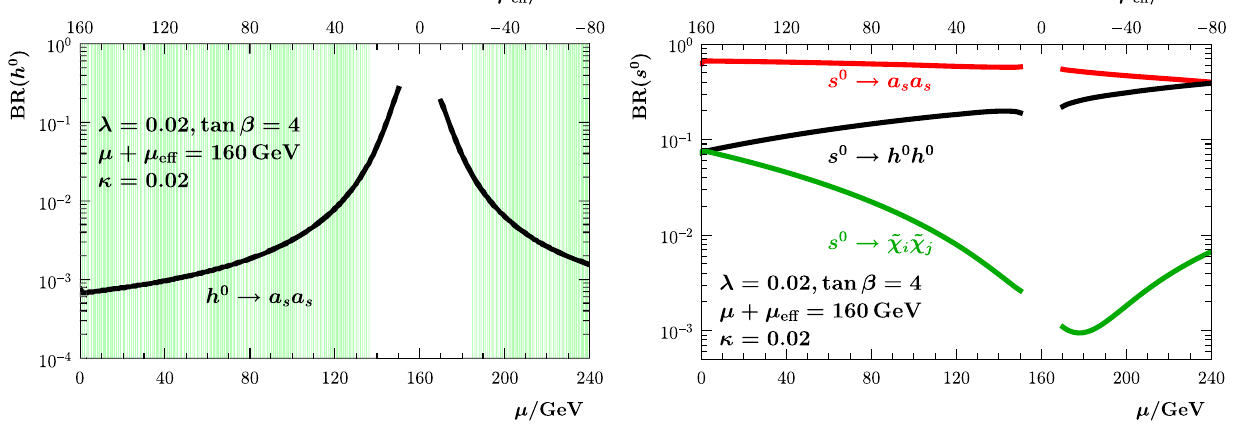
Fig. 10 (left)Branchingratioof h 0 intoapairoflight CP -oddsinglets; (right) Branching ratios of s 0 into non-SM particles and Higgs bosons; both for the same scenario as in Fig.9. The green area indicates com-